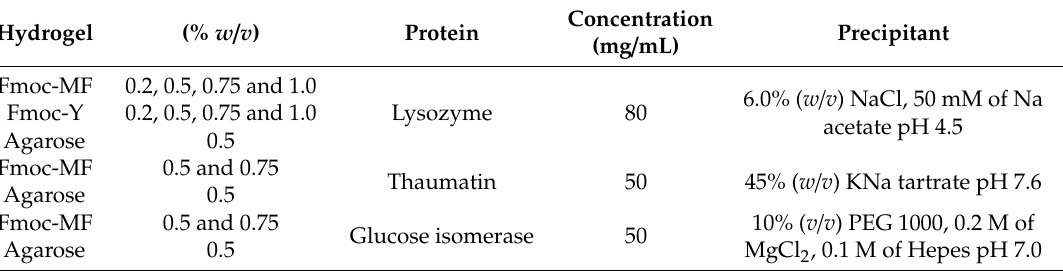
Table 1. Resume of crystallization